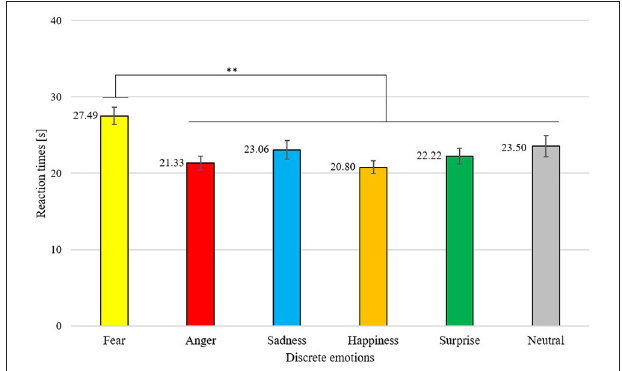
FIGURE 7 | Mean reaction times in seconds for each discrete emotion. Error bars depicted in standard errors ( SE ). ** p <